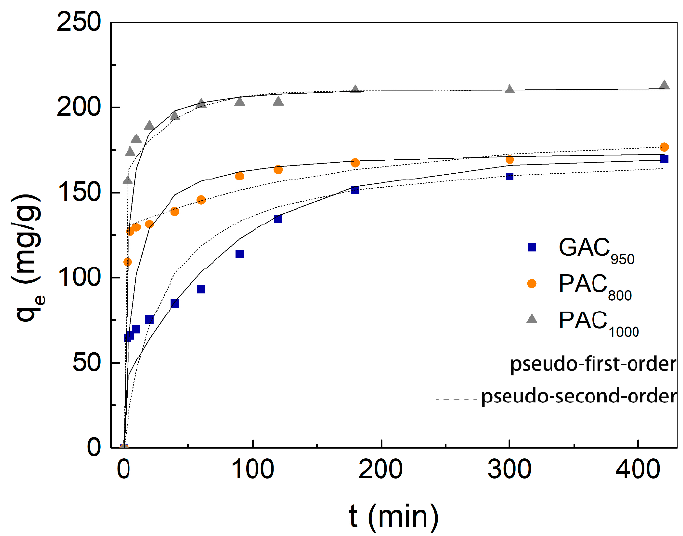
Figure 4. Kinetic curves for phenol adsorption onto AC.